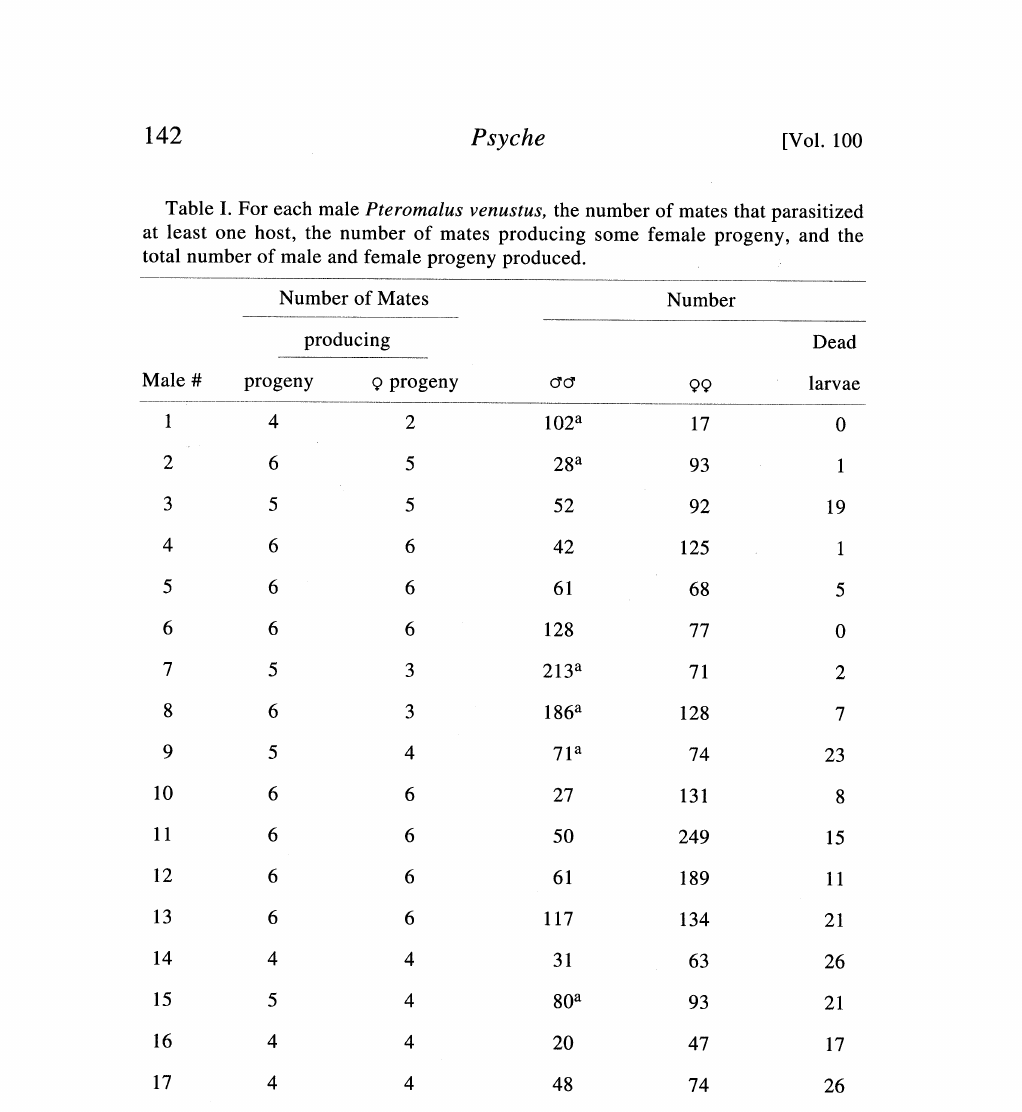
Table I. For each male Pteromalus venustus, the number of mates that parasitized at least one host, the number of mates producing some female progeny, and the total number of male and female progeny